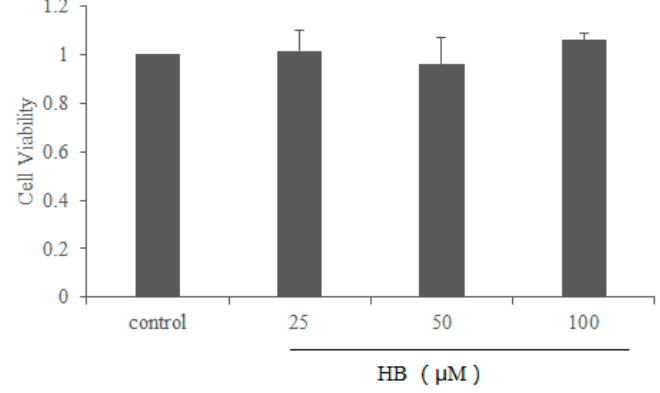
Figure 2. Effects of HB on the cell viability in RAW 264.7 Cells. RAW 264.7 Cells were cultured with different concentrations of HB (0, 25, 50, and 100 μ M) for 24 h. The cell viability was detected by MTT assay. The values are presented as means ± SD of three independent experiments.